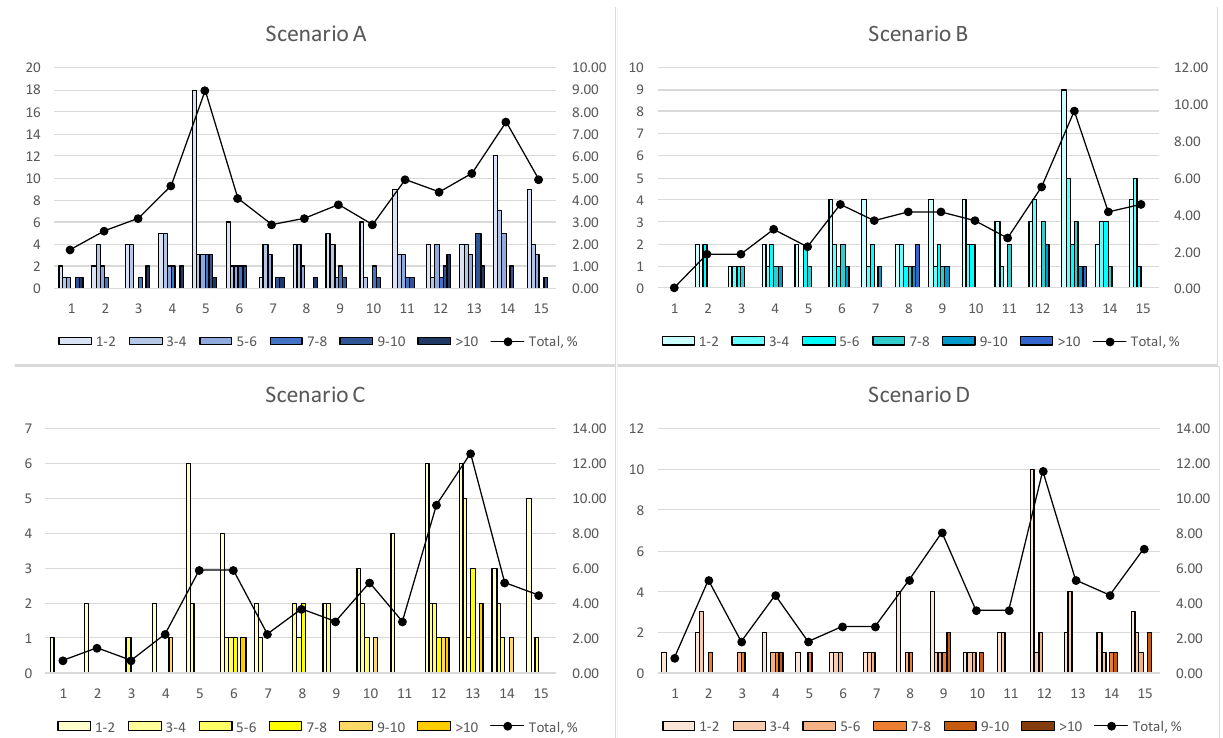
Figure 6. Number of rods (y axis) replaced across the x axis as time (years) in the lifecycle of the Afridev when water point has no rehabilitation.